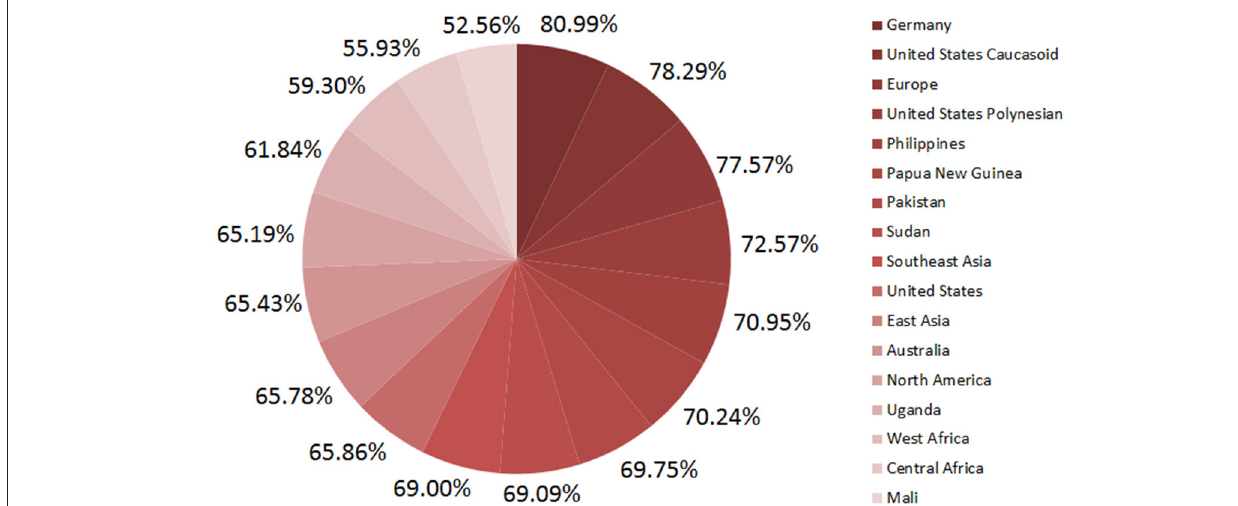
FIGURE 2 | Population coverage of predicted epitopes.